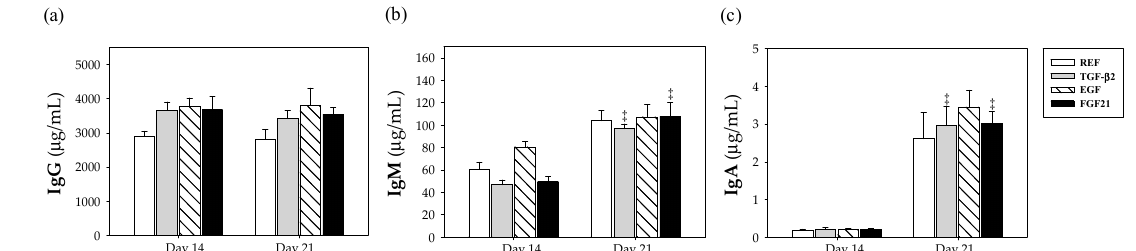
Figure 1. E ff ect of growth factor supplementation on plasma ( a ) IgG, ( b ) IgM and ( c ) IgA from the four groups, i.e., reference (REF), transforming growth factor- β 2 (TGF- β 2), epidermal growth factor (EGF) and fibroblast growth factor 21 (FGF21), over the suckling period (day 14 and 21). Results are expressed as means ± S.E.M. ( n = 9 pups per group). Statistical di ff erences: ‡ p < 0.05 vs. same group at day 14.